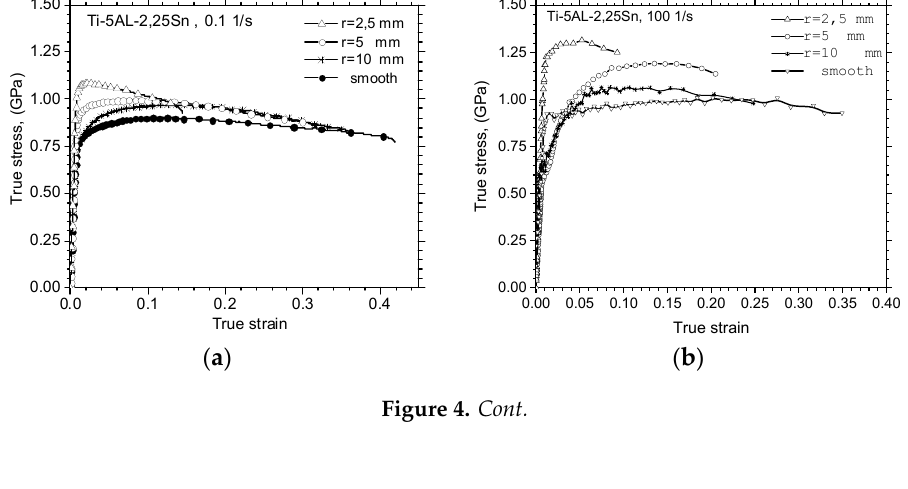
Figure 3. Force versus displacement of Ti ‐ 5Al ‐ 2.5Sn specimens under tension at strain rates of 0.1, 100, and 1000 s − 1 ; ( a ) specimens without notch; ( b ) specimens with notch radius R = 10 mm; ( c ) R = 5 mm; and ( d ) R = 2.5 mm.